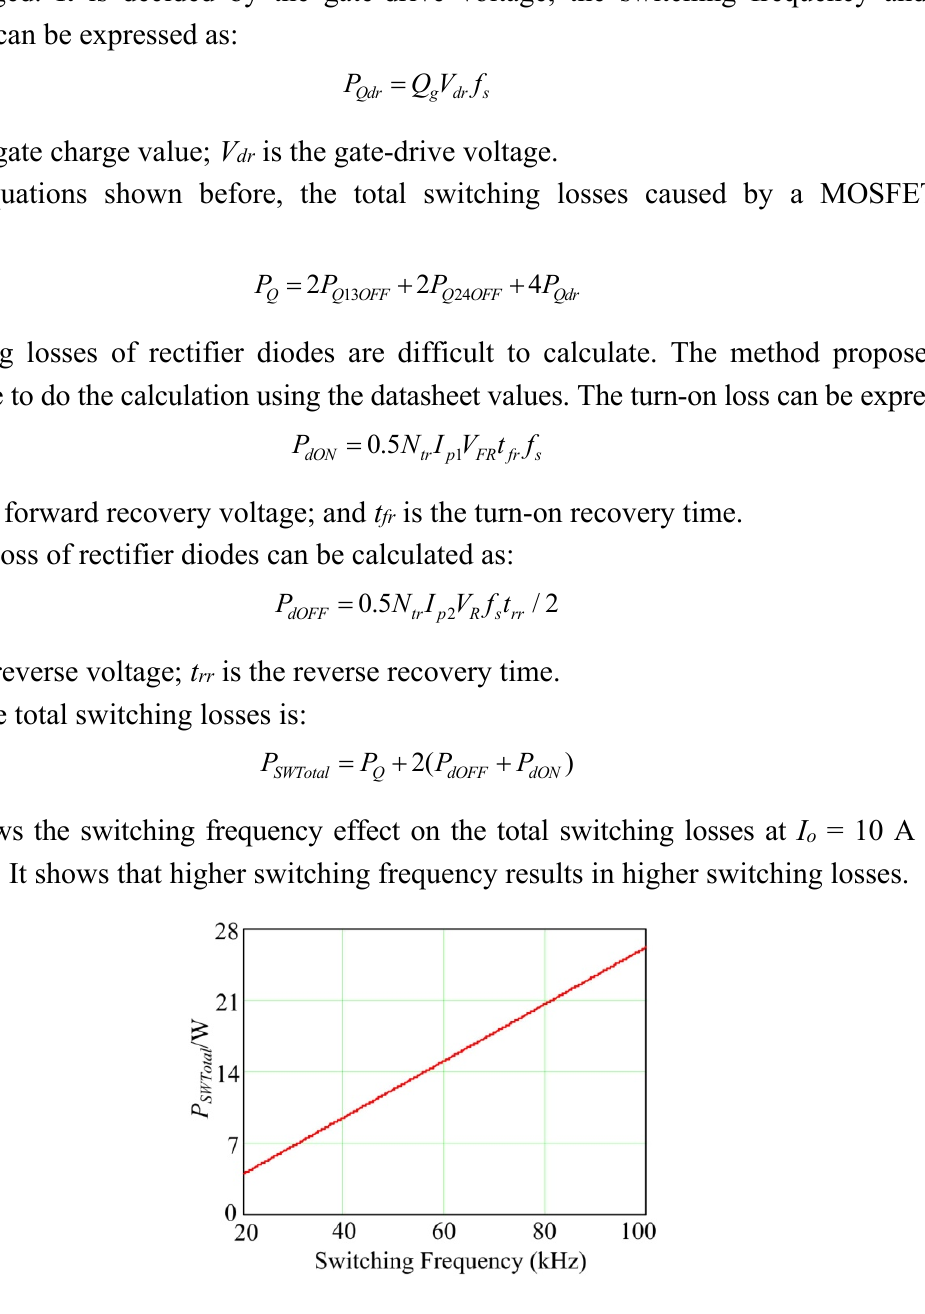
Figure 4. Switching losses versus switching